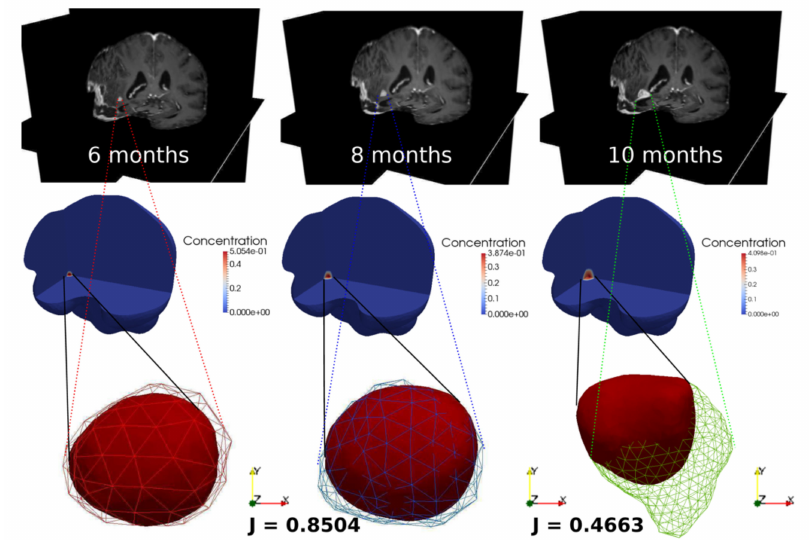
Figure 3. Simulated GBM evolution ( bottom ) against the MRI images ( top ) at 6 months, 8 months and 10 months after surgery. J is the Jaccard index, the color bars refer to the GBM volume